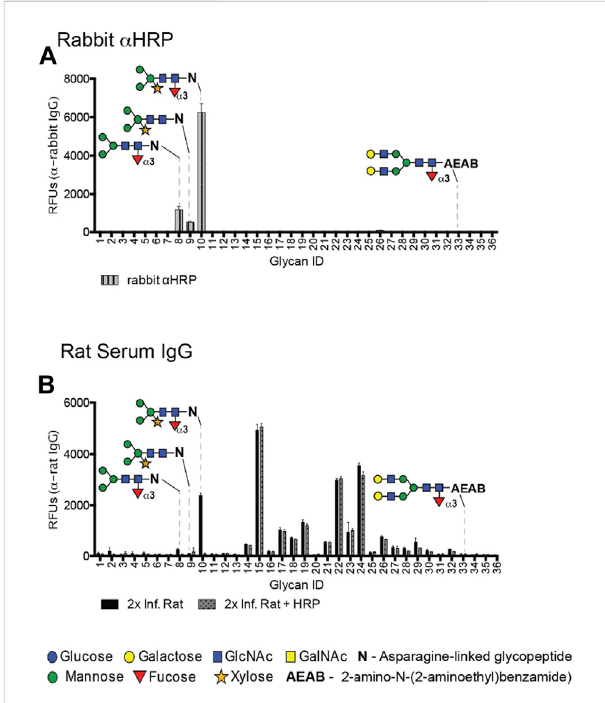
FIGURE 2 Rat antisera and rabbit anti-HRP share similar speci fi city for CX/ CF on the DSA. (A) Rabbit anti-HRP screened on the DSA at 20 μ g/mL and detected with goat anti-rabbit IgG-Alexa 488. (B) Rat serum at 1: 50 screened for IgG on the DSA with or without pre-incubation with 100 µg HRP in the binding